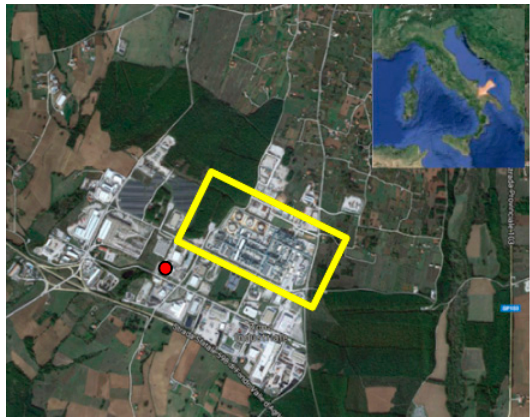
Figure 1. Map of the monitored site. The red dot shows the position of the e-nose; the yellow rectangle shows the position of the plant. On the upper right of the figure, an inset with the position of the site on the Italian territory is shown by an arrow.